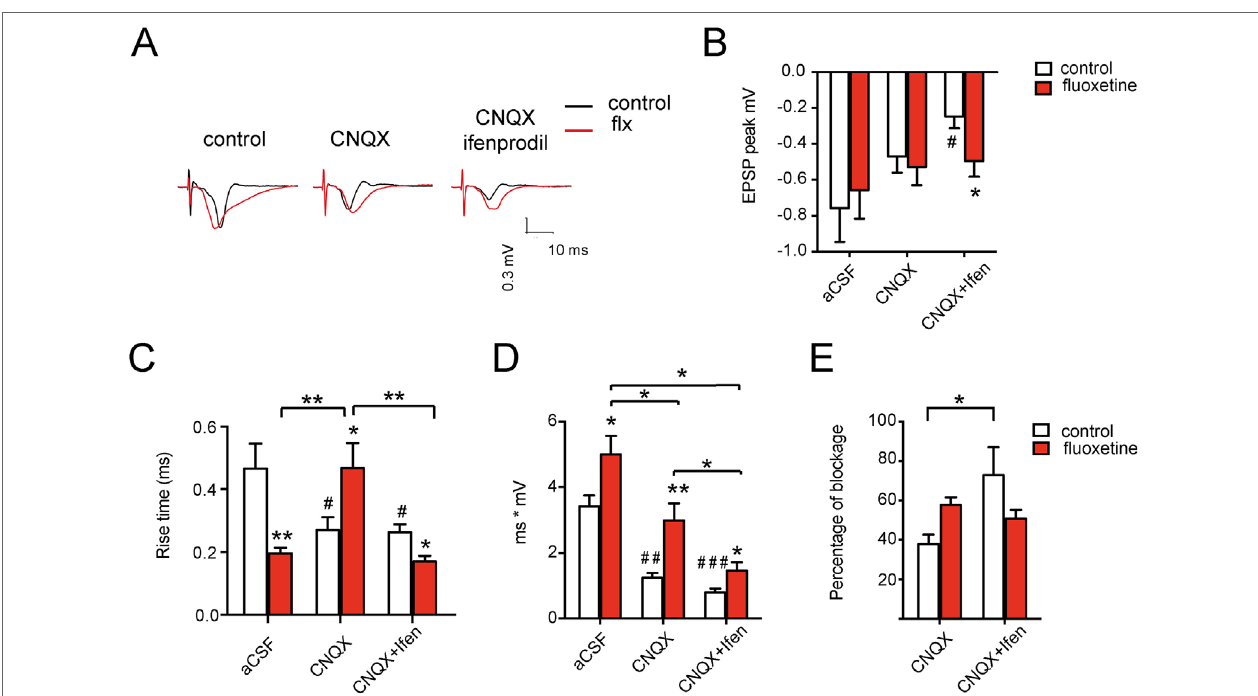
FIGURE 4 | Chronic fluoxetine treatment modifies the postsynaptic response in the auditory cortex of rats. Different parameters of the fEPSPs were measured after stimulation in layer I and recording in layer II–III: (A) Representative recordings in slices from vehicle or fluoxetine-treated animals (left) followed by the NMDA- mediated response (in the presence of CNQX to block AMPA receptors) (middle) and of the GluN2A-mediated response (in the presence of CNQX + ifenprodil to block AMPA and GluN2B-containing receptors) (right). (B) Peak fEPSPs, (C) rise time (or the time at which the 67% of the peak potential is achieved), (D) total postsynaptic potential (area under the curve), and (E) percentage of blockade of the total fEPSP by CNQX (NMDA component) or by CNQX + ifenprodil (GluN2A component). Slices were perfused with Mg-free aCSF (control recording) or with aCSF in the presence of CNQX and then in the presence of CNQX + ifenprodil. For each condition, at least 32 slices were recorded, obtained from 16 animals ( n = 8 control and n = 8 fluoxetine). Figures show the mean ± SEM. One way- ANOVA followed by post hoc Bonferroni test was used. * p ≤ 0.05; ** p < 0.01 relative to the control within each drug condition (i.e., within each pair of red vs. white bar). For indicated comparisons among groups, unpaired t -tests were used # p ≤ 0.05; ## p < 0.01, ### p < 0.001 relative to the first bar (aCSF-control without drug